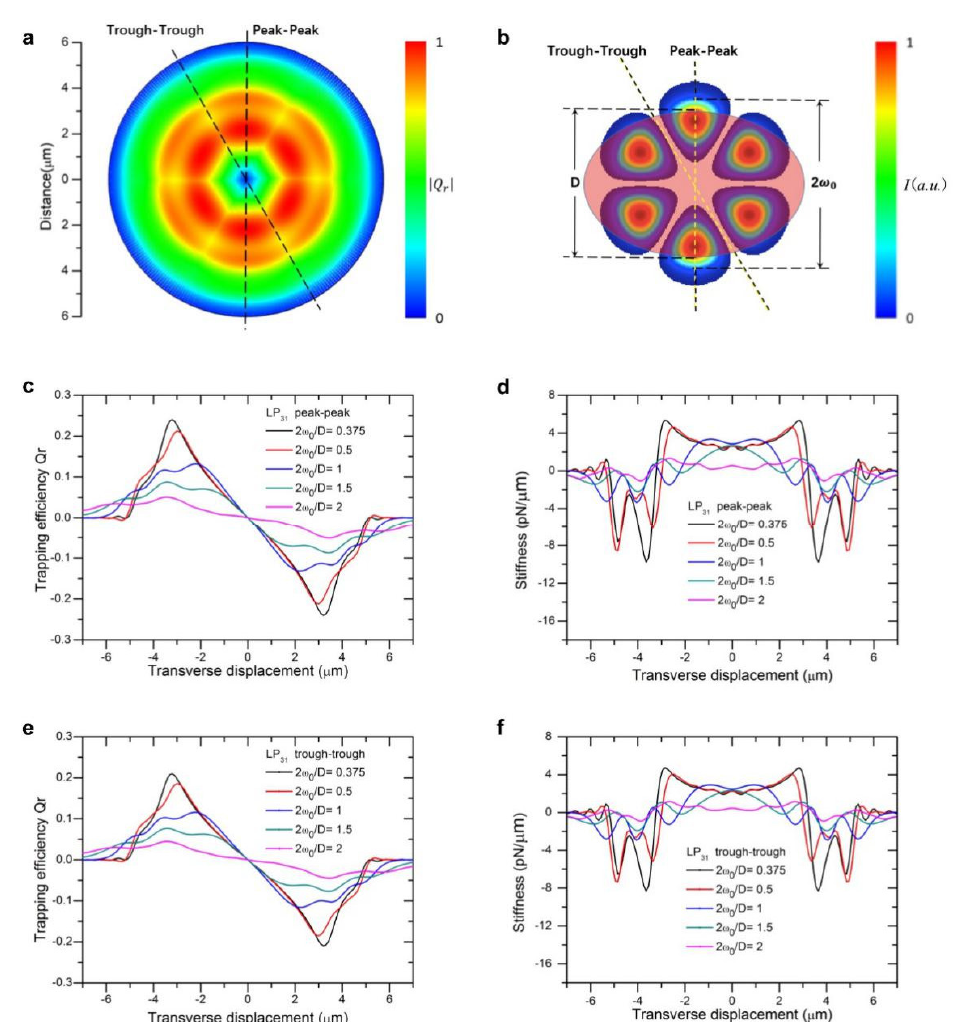
Figure 3. Landscape of trapping force of an LP 31 beam. ( a ) Normalized 2D trapping force distribution of LP 31 mode; ( b ) Cross-sectional view of a spheroid cell trapped by an LP 31 beam; ( c ) LP 31 beam trapping efficiency vs. displacement curves along the peak-to-peak direction; ( d ) LP 31 beam trapping stiffness vs. displacement curves along the peak-to-peak direction; ( e ) LP 31 beam trapping efficiency vs. displacement curves along the trough-to-trough direction; ( f ) LP 31 beam trapping stiffness vs. displacement curves along the trough-to-trough direction.